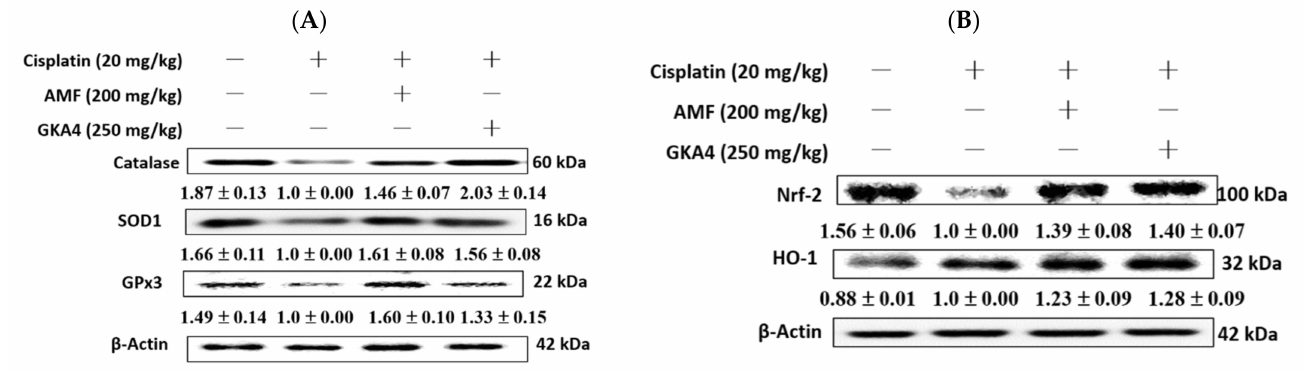
Figure 5. In renal tissues, the effects of GKA4 on the protein expression induced by cisplatin, including ( A ) anti-oxidative enzymes (catalase, SOD1, and GPx3) and ( B ) HO-1 and Nrf2. The protein levels of HO-1 and Nrf2 protein expression in renal homogenates were assessed by western blot analysis after the cisplatin challenge. Protein bands were analyzed by densitometric analysis. Experiments were performed at least three times, and representative images are shown. Plus signs: with drug; Minus signs: without